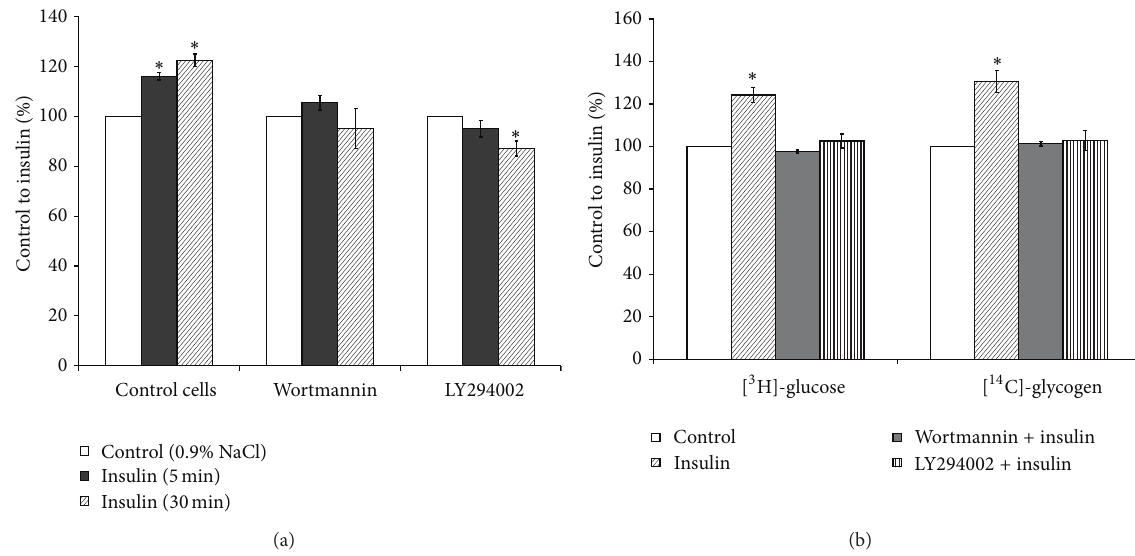
Figure 3: Effects of inhibitors of phosphoinositide-3-kinase on phospholipase D activity and glucose metabolism in insulin-stimulated hepatocytes. (a) Phospholipase D activity, (b) uptake of 2-D-[ 3 H]glucose and incorporation of D-[U 14 C]glucose into glycogen. Effect of insulin on PLD activity and glucose metabolism in the wortmannin- or LY294002-treated hepatocytes was determined as described in the Methods. ∗ 𝑝 < 0.05 , insulin versus